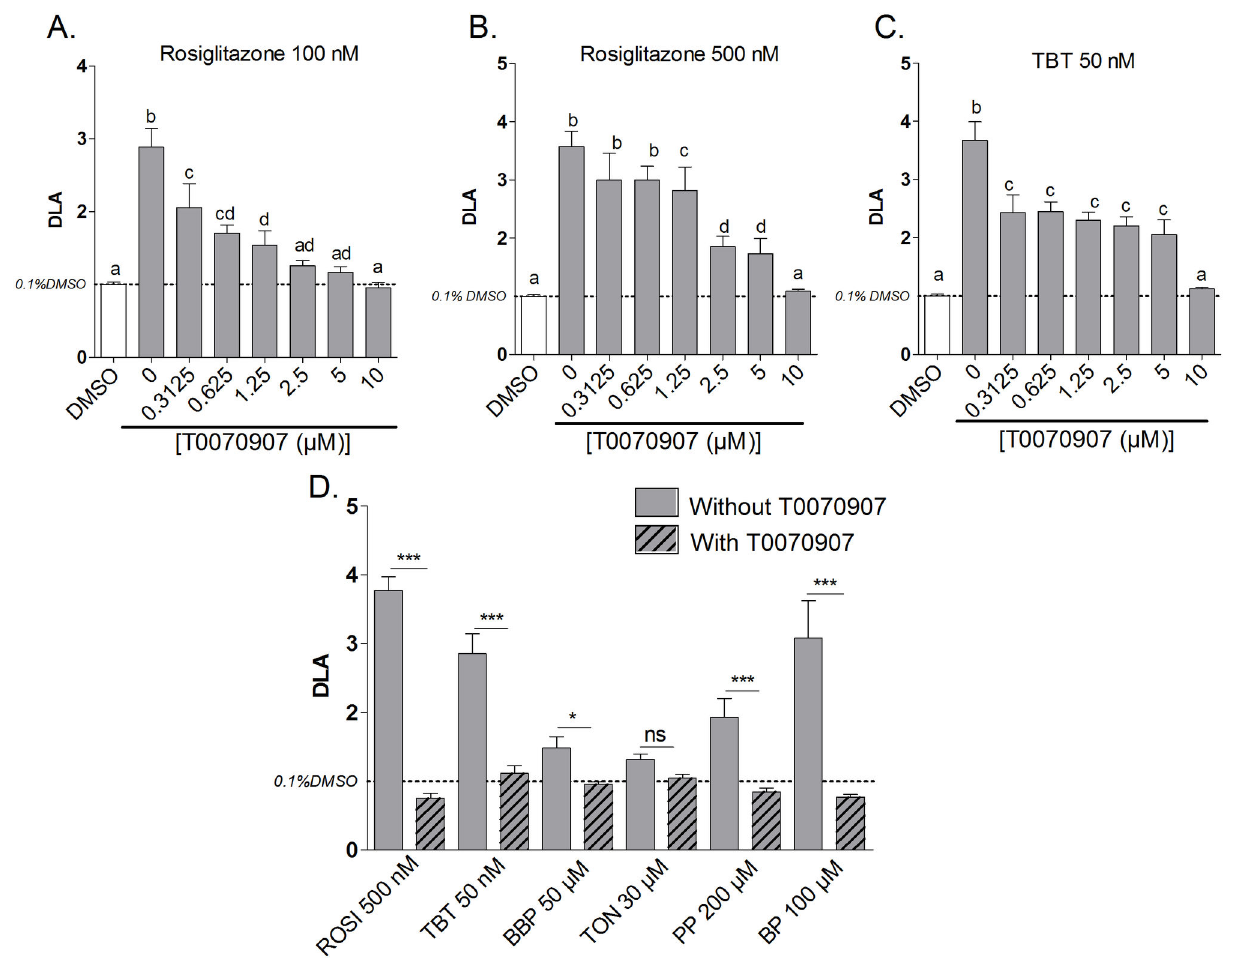
Figure 8. PPARγ dependency of the obesogenic effects of reference and test compounds. 3T3-L1 cells were exposed to Rosiglitazone 100 nM (A), 500 nM (B) TBT 50 nM (C) and screened obesogenic compounds (D) together with a concentration range of the PPARγ antagonist T0070907(A, B, C) or with and without 10 µM T0070907 (D). After 10 days of exposure fluorescent quantification of lipid accumulation was performed using Nile red staining. Data represent the degree of lipid accumulation (DLA) (mean ±SD) of 4 replicates. Significant differences (p≤0.05) between conditions are indicated with different letters for the optimisation tests (A, B, C) and significant differences between screened obesogens with and without T0070907 (D) are indicated with asterisks (*p≤0.05; **p≤0.01; ***p≤0.001) (One Way ANOVA Tukey’s post hoc